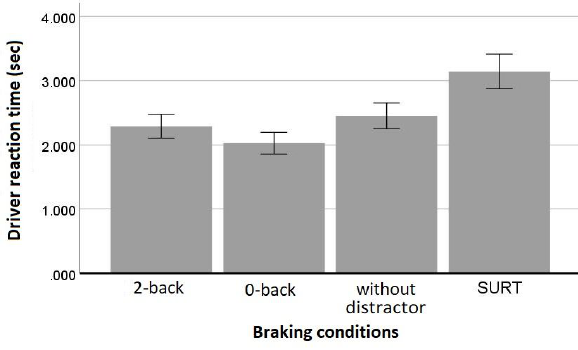
Figure 4: The reaction times in emergency braking conditions de- pending on distractors, N = 95.